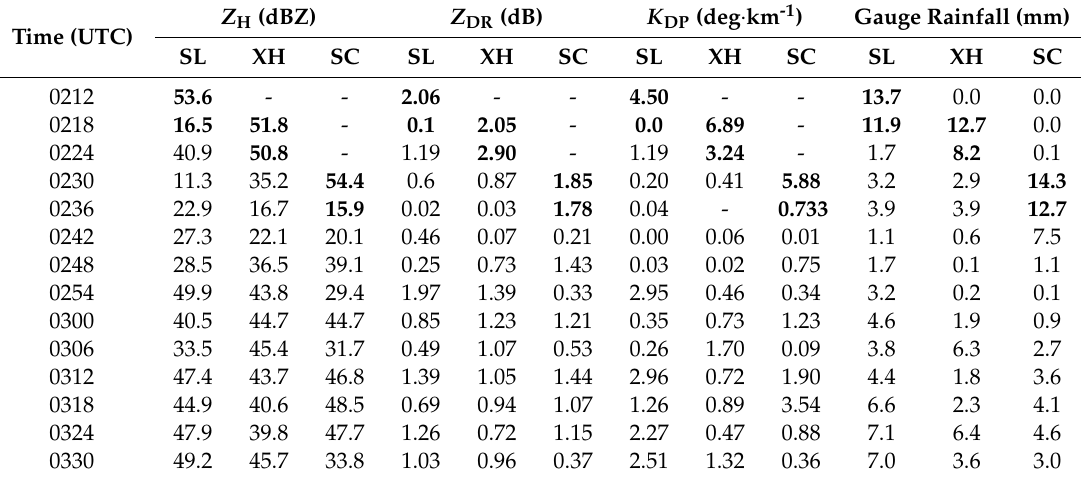
Table 2. Radar measurements and six-minute gauge rainfall measurements of the three stations